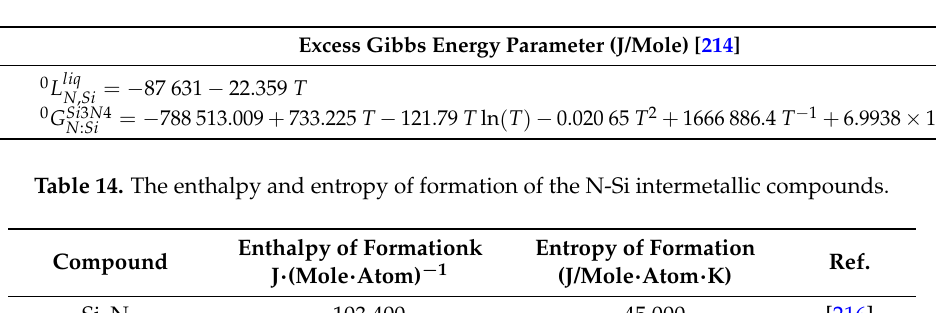
Figure 27. The calculated condensed N-Si phase diagram at 7.5 × 10 9 Pa [214]. Table 12. Optimized model parameters of the N-Si system. Table 13. Optimized model parameters of the N-Si system.